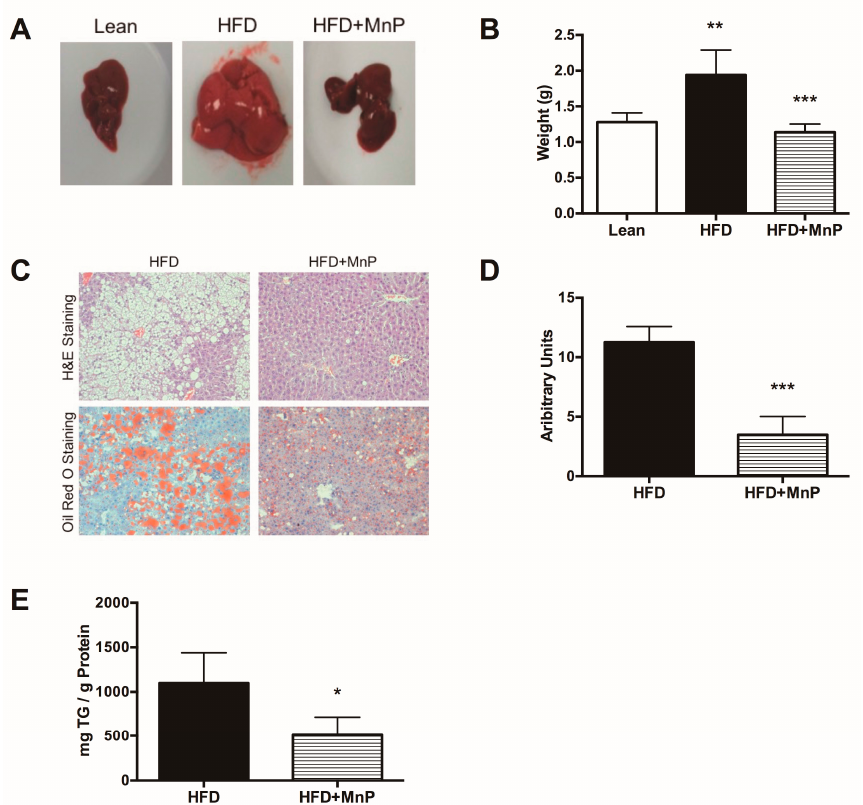
Figure 3. Redox modulation reduces liver steatosis and hepatic lipid accumulation in HFD-fed mice. ( A ) Gross examination of livers excised from lean mice and mice fed HFD for 12 weeks, with or without MnP treatment. Representative images are shown. ( B ) Weights of livers excised after 12 weeks of feeding. Data are displayed as mean ± SD, n = 5 per group. Significance was calculated by one-way ANOVA with a Tukey post-test of multiple comparisons. ** indicates p ≤ 0.01, *** indicates p ≤ 0.001. ( C ) H&E (top row) and Oil Red O (bottom row) staining of livers after 12 weeks of HFD feeding, with or without MnP treatment. Representative images are shown with a 20× magnification. ( D ) Quantification of Oil Red O staining. Data are displayed as mean ± SD, n = 4 mice per group. Three images per section were analyzed using Image J (NIH, Bethesda, MD, USA). Significance was calculated by t -tests. *** indicates p ≤ 0.001. ( E ) Hepatic intracellular triglyceride (TG) levels, defined as mg TG per gram of total liver protein, were measured by acetone extraction. Data are displayed as mean ± SD. n = 5 mice per group. Significance was calculated by t -tests. * indicates p ≤ 0.05.